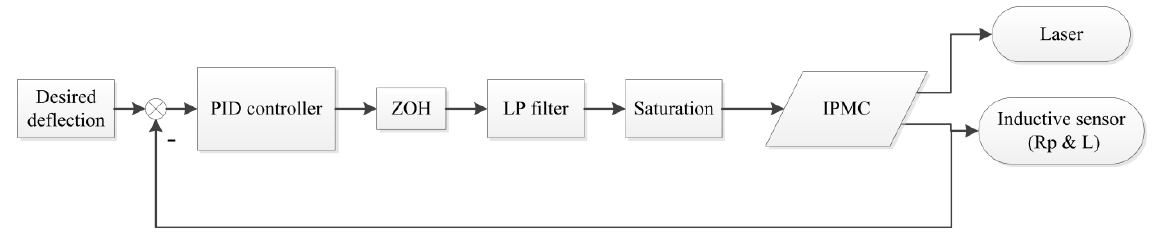
Figure 8. Block diagram of the PID controlled IPMC deflection system.